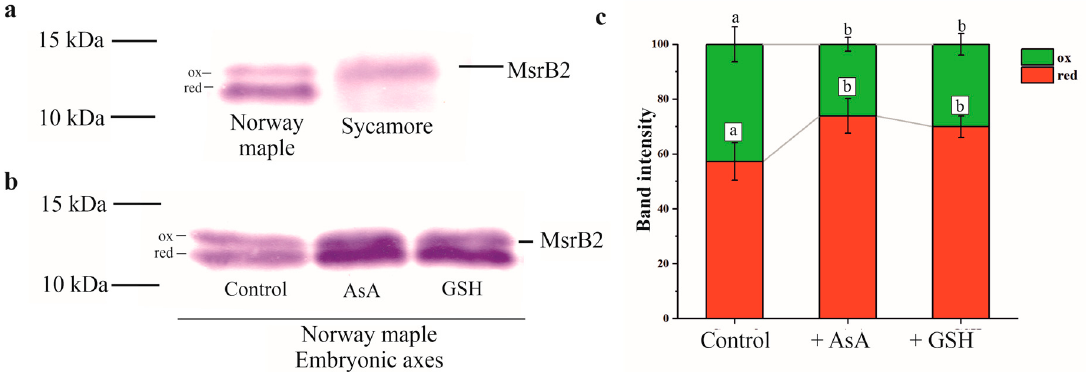
Figure 9. Characterization of the redox state of the MsrB2 protein. ( a ) Immunoblot analyses of MsrB2 proteins in two Acer species. Two bands corresponding to two redox states are visible only in Norway maple. ( b ) Immunoblot analyses of MsrB2 proteins using non-treated Norway maple protein extract (control) and protein extract incubated in vitro with the reducing reagents, ascorbic acid (AsA, lane 2) or GSH (lane 3). ( c ) Densitometric analysis of the oxidized and reduced forms of MsrB2. The data are the means of three independent replicates ± the STDs. The same letters indicate groups that are not significantly di ff erent according to Tukey’s